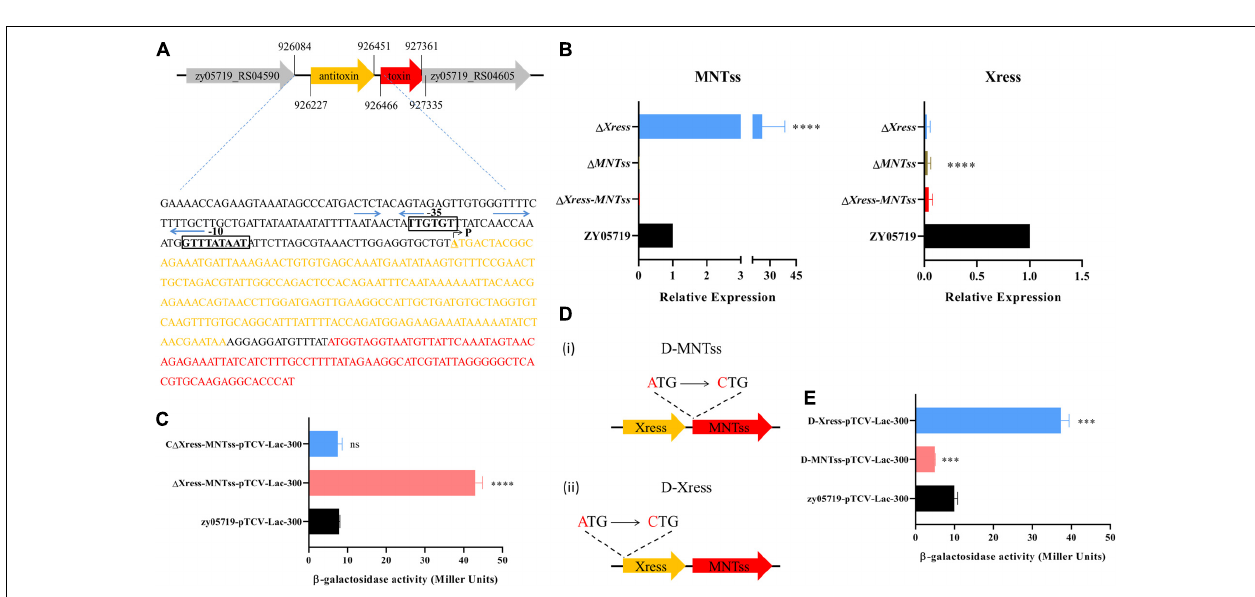
FIGURE 1 | Effect of toxin and antitoxin induction on growth of E. coli Top10 cells. Toxins were linked to pBADHisA and pBADHisA-pelB plasmids and transformed into E. coli Top10 cells. Cytoplasmic toxicity in cells expressing the toxin on pBADHisA (A) with 0.2% L -arabinose. Periplasmic toxicity in cells expressing the toxin on pBADHisA-pelB (B) with L -arabinose. (C) Viability of strains expressing T2/T3, MNTss, T6, and RHSse. To quantitate CFU per milliliter, cells were diluted and plated on LB agar plus 100 ug of ampicillin/ml at the times indicated. Growth of E. coli Top10 cells containing the pBADHisA-pelB-Xress-MNTss plasmid with 0.2% L -arabinose (D) to determine the neutralization effect of the antitoxin. Culture growth was monitored by measuring OD 600 every hour. Growth curves represent at least three independent experiments.